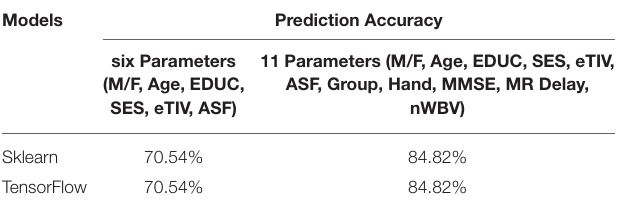
TABLE 2 | Prediction accuracy for